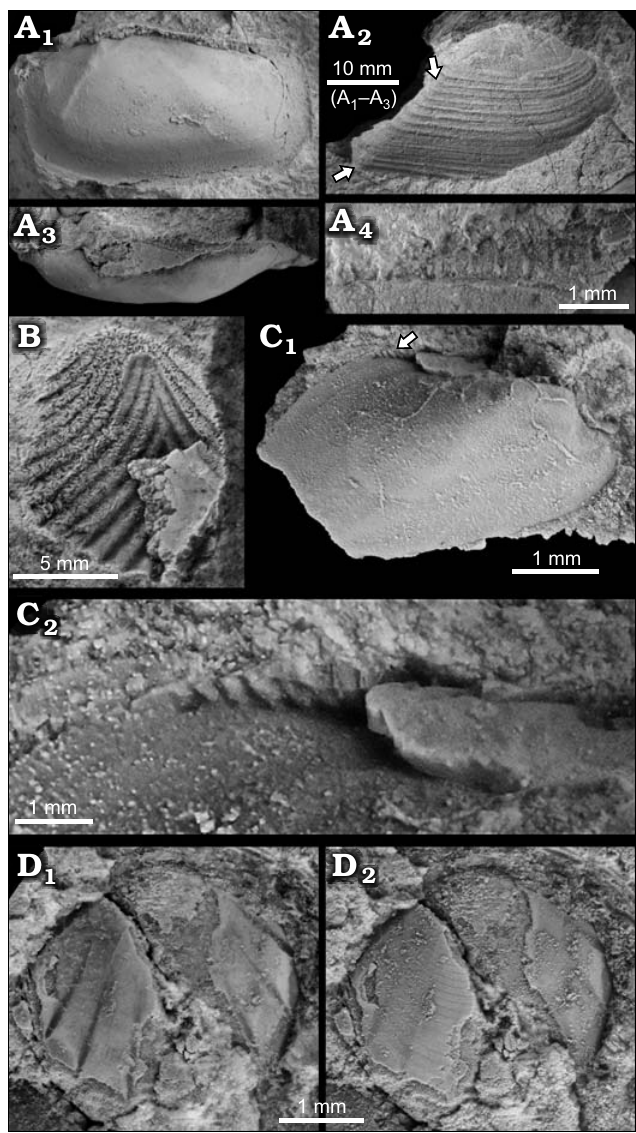
Fig. 2. Protobranch and pteriomorph bivalves from early Oligocene seep deposits from the Cerro La Salina (block 1, A; block 6, D; block 9, C) and Belén seep deposit (B), Talara Basin, northern Peru. A . Malletiid Neilo altamirano sp. nov. (NRM Mo187001, holotype), internal mold in lateral view (A 1 ); external mold in lateral view (A 2 ), arrows indicating the pos- terior ridge; view on the dorsal side (A 3 ); close-up on the taxodont hinge dentition (A 4 ). B . The possible nuculid Acila ? sp. (NRM Mo187002), ex- ternal mold of outer shell surface. C . The bathymodiolin Idas sp. (NRM Mo187003), internal mold of the entire specimen (C 1 ), arrow indicating the taxondont teeth; close-up on taxodont teeth on posterodorsal shell mar- gin (C 2 ). D . Propeamussiidae indet. (NRM Mo187004), uncoated speci- men showing internal radial ridges (D 1 ); specimen coated with ammoni- um-chloride, highlighting external sculpture (D 2 ridge well defined; sculpture of irregularly spaced, blunt commarginal ribs, interspaces roughly twice the width of the ribs. Dimensions (in mm).—The holotype NRM Mo187001, L = 20, H = 12, and the single valve ca. 4 mm thick.